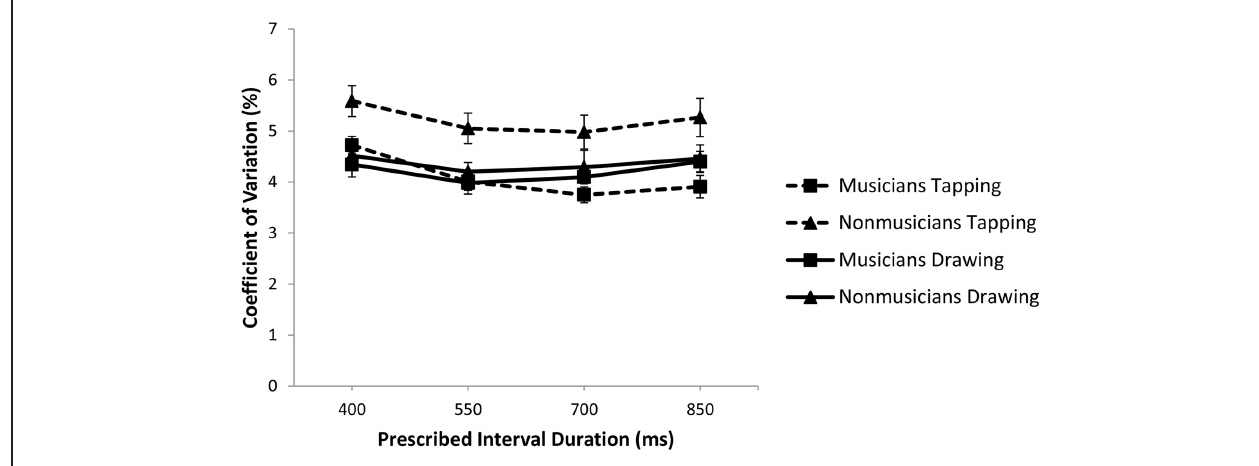
Frontiers in Human